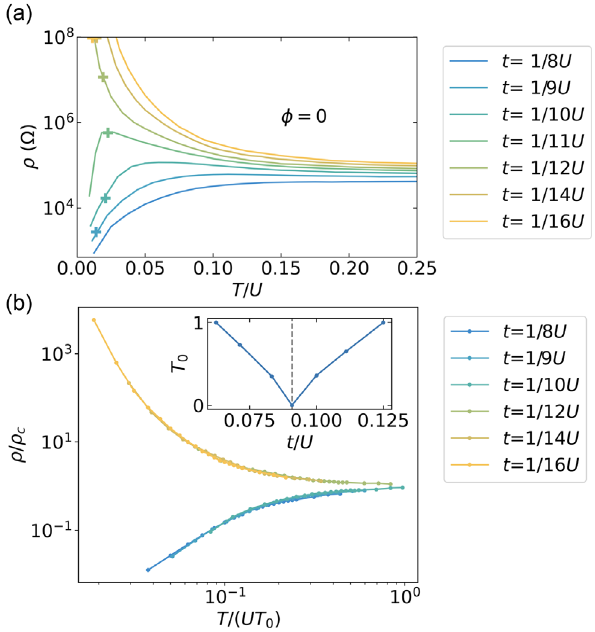
FIG. 9. (a) Resistivity near the paramagnetic Mott-insulator transition for ϕ ¼ 0 plotted in log scale with temperature T and hopping t in unit of interaction. The “ plus ” symbol marks the magnetic transition temperature. (b) Resistivity curves collapse onto two branches. The resistivity is scaled by the resistivity at U ¼ 11 t . The temperatures are scaled by a t -dependent T 0 to collapse the data. The inset shows the value of T 0